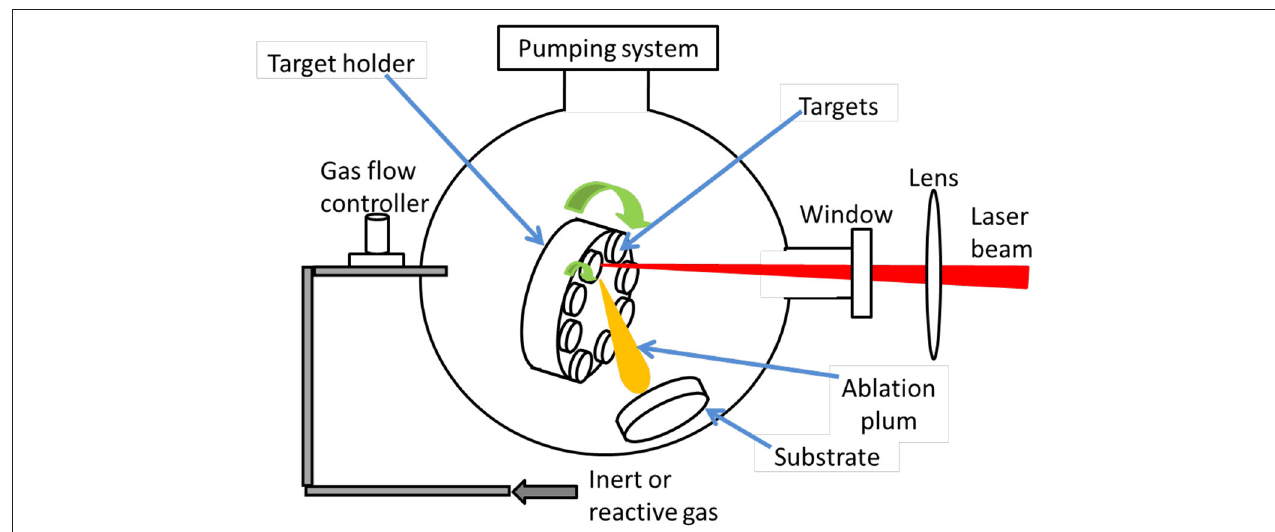
FIGURE 6 | Schematic diagram of a representative laser deposition tool.